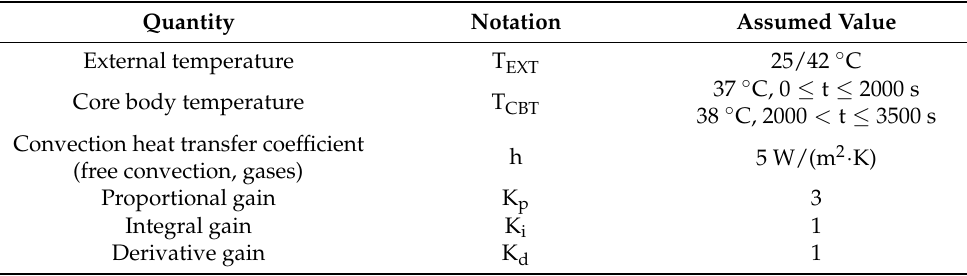
Table 2. Assumed values in the finite element